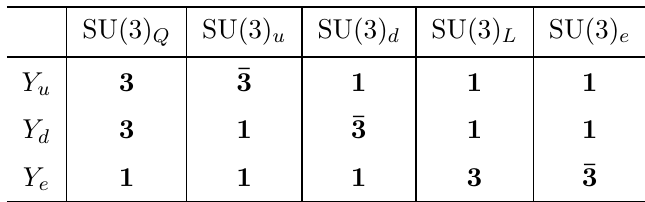
Table 1 . Flavor transformation properties of the Yukawa matrices treated as